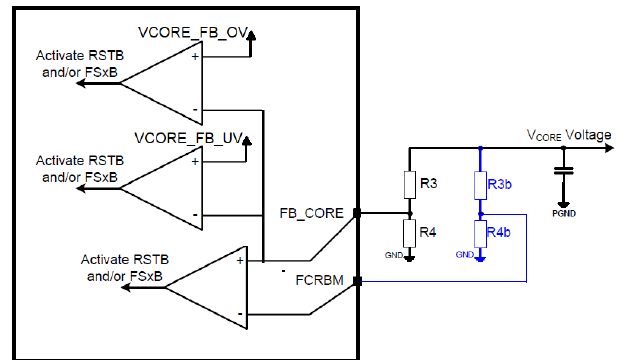
Figure 10. F6512 SBC internal safety activation circuit. Reproduced from [1].